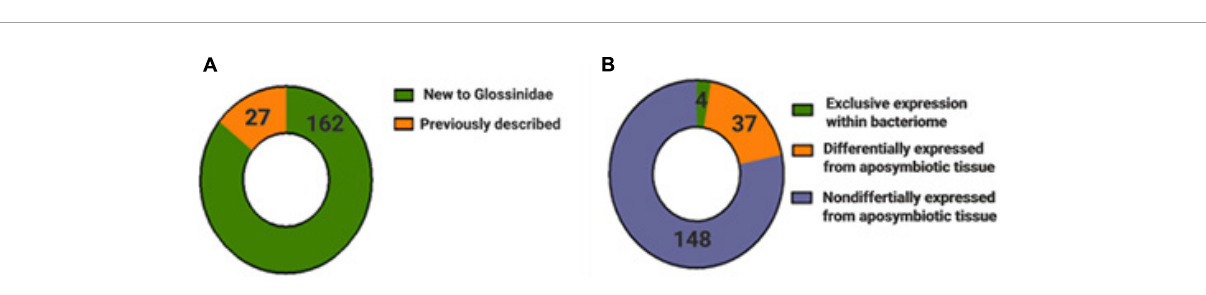
FIGURE3 Donut charts for the miRNAs identified within tsetse bacteriome and aposymbiotic tissue. (A) The vast majority of identified miRNAs (86%) have not been previously documented in the Glossinidae family. (B) Most miRNAs identified were not differentially expressed between the bacteriome and aposymbiotic tissue ( ∼ 78%) while 22% showed differential expression. A total of 4 miRNAs (2%) had exclusive expression within bacteriomes. The 4 putative miRNAs considered to be unique to Glossina (1 in G. morsitans and 3 in G. brevipalpis ) are not included in these